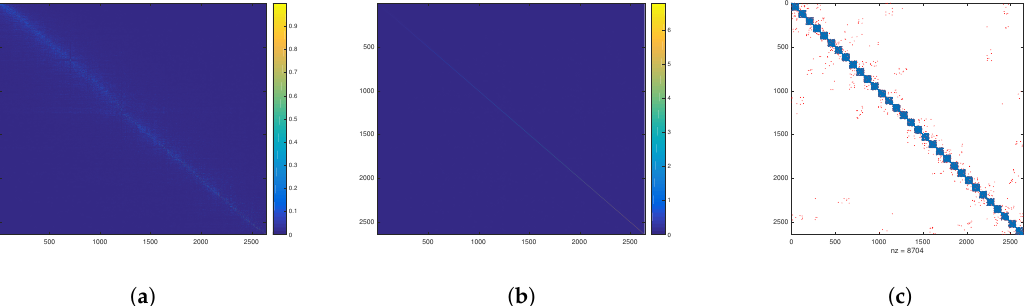
Figure 7. ( a ) Absolute value of inner products between the approximate, ˆ U , and the true graph modes, [ ˆ U T U ] i , j i.e., . ( b ) Absolute value of the approximate diagonalization of the original Laplacian, | |